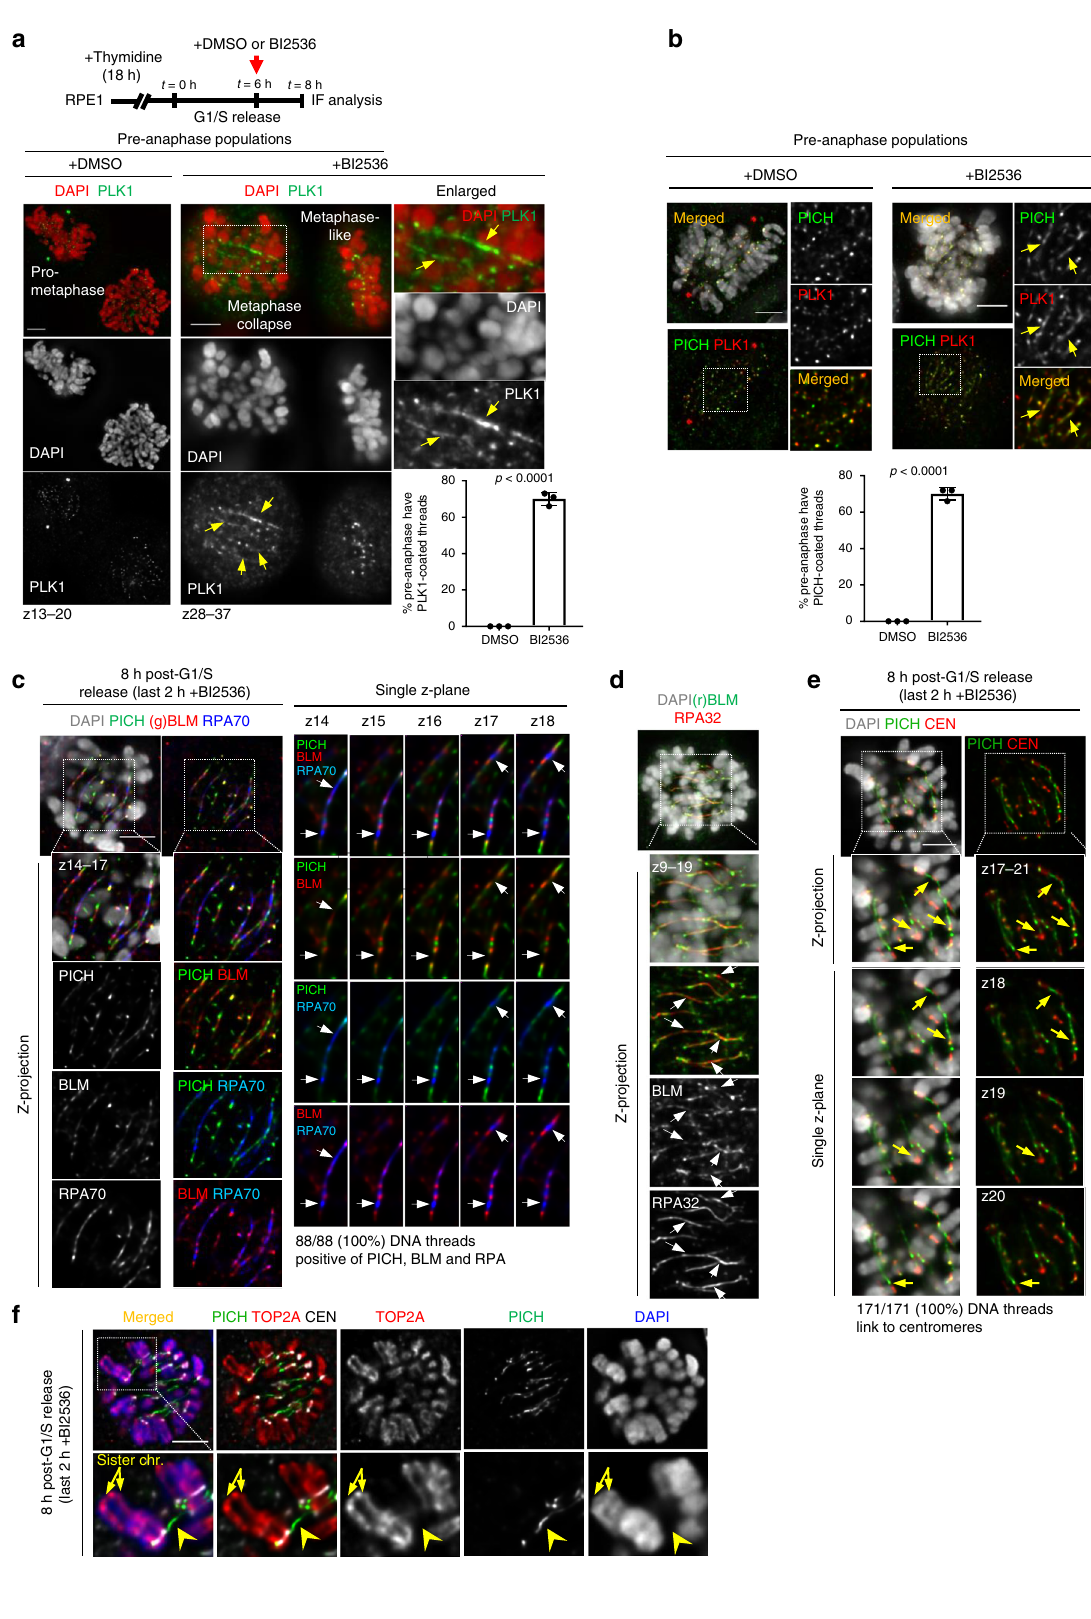
frequency (Supplementary Fig. 3d). These data indicate that the formation of centromere DNA linkages likely results from a loss of M-phase speci fi c function of PLK1. However, thymidine